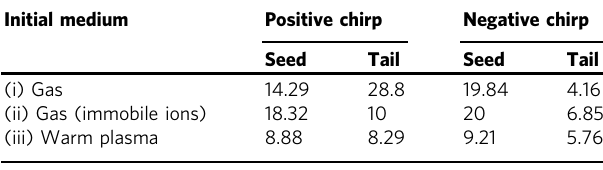
Columns Seed correspond to integrated energy around the seed temporal region after the interaction. Columns Tail corresponds to integrated energy trailing the seed pulse.